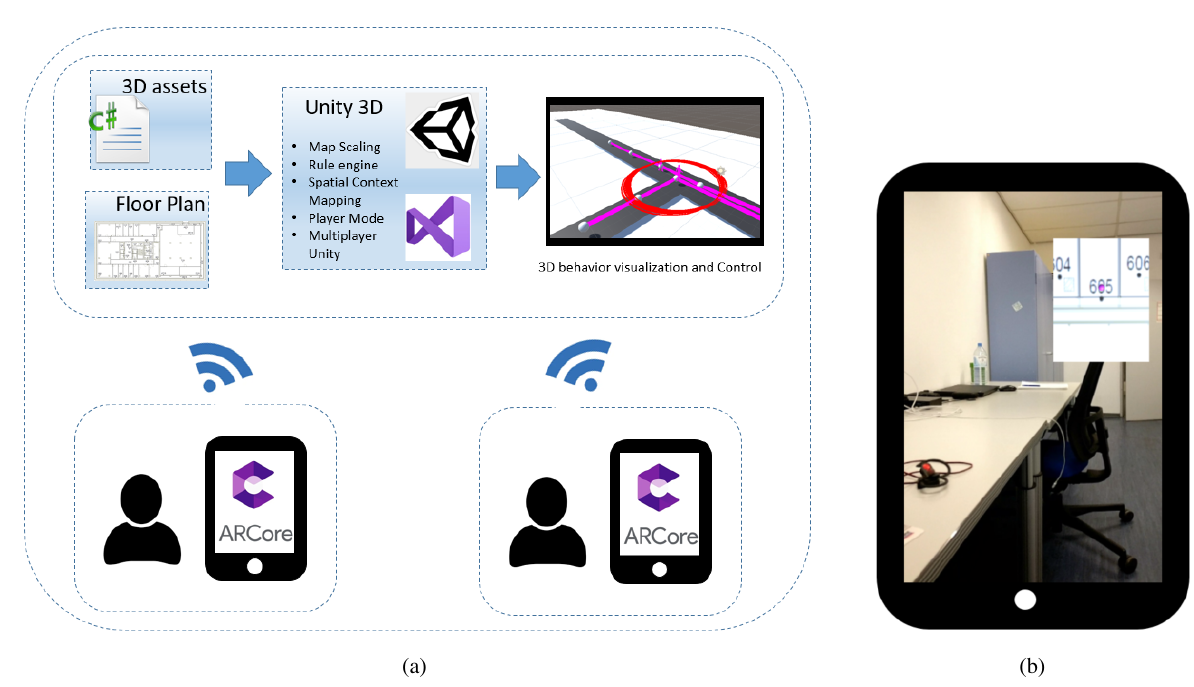
Figure 4: (a) System implemented in Unity and the different components part of the implementation. (b) ARCore based tracking system on the smartphone with only the single user navigation